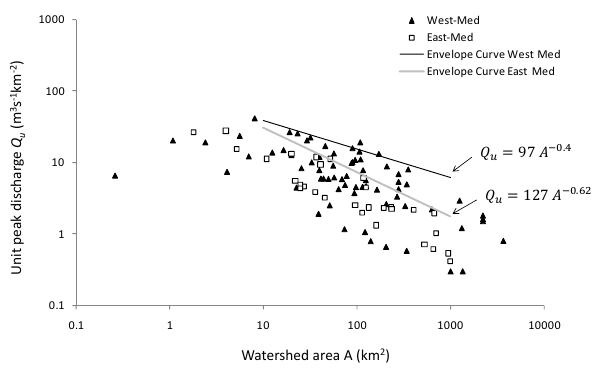
Fig. 1. Peak unit discharges of extreme flash floods in the two re- gions and envelope curves.